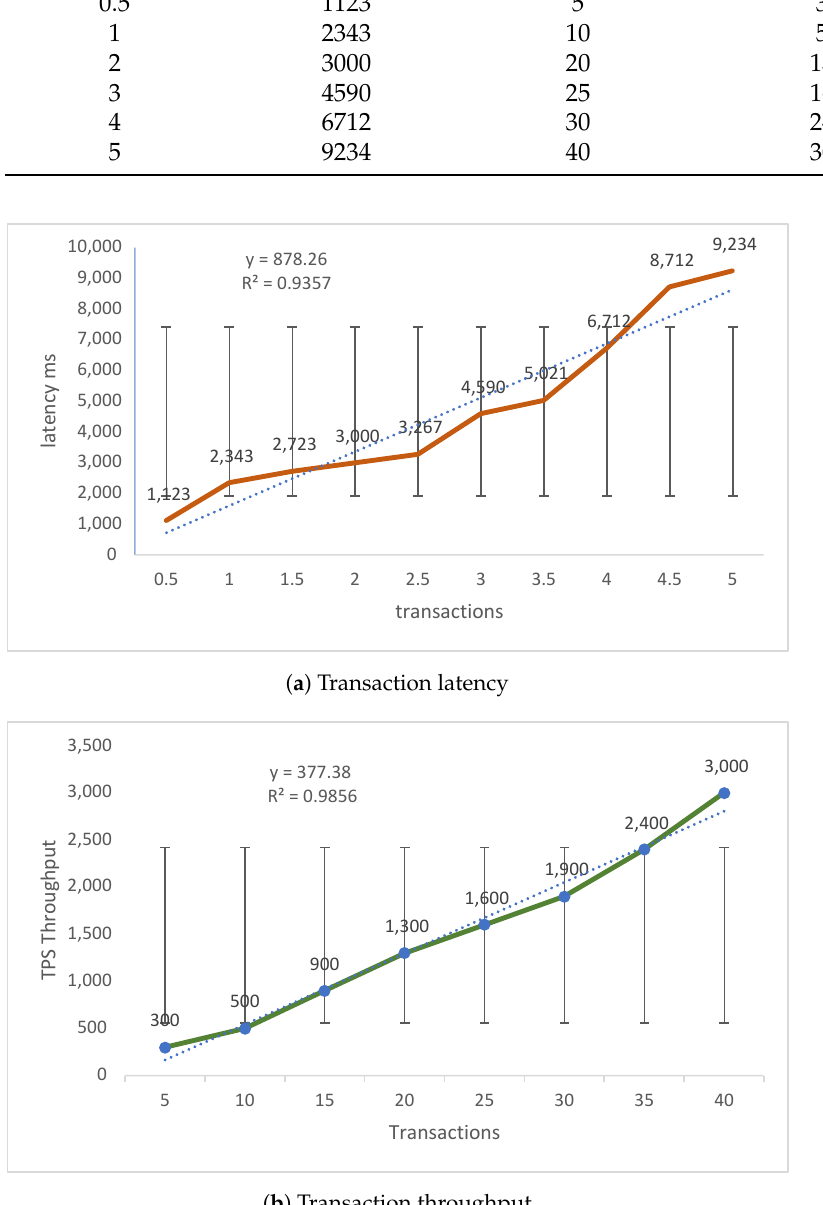
Figure 13. Comparison of transaction latency and